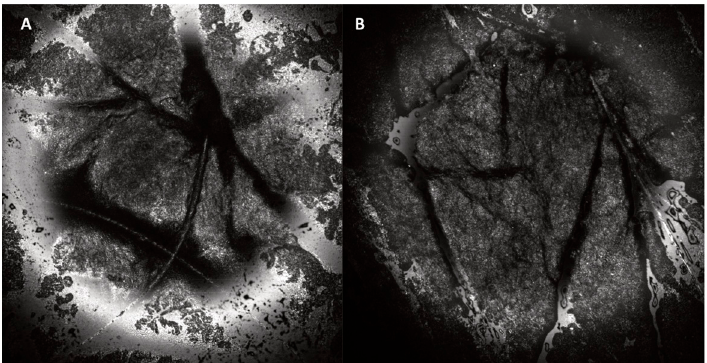
Figure 4. Representative reflectance confocal microscopy images of the stratum corneum at baseline ( A ) and 30 min after cream application ( B ).